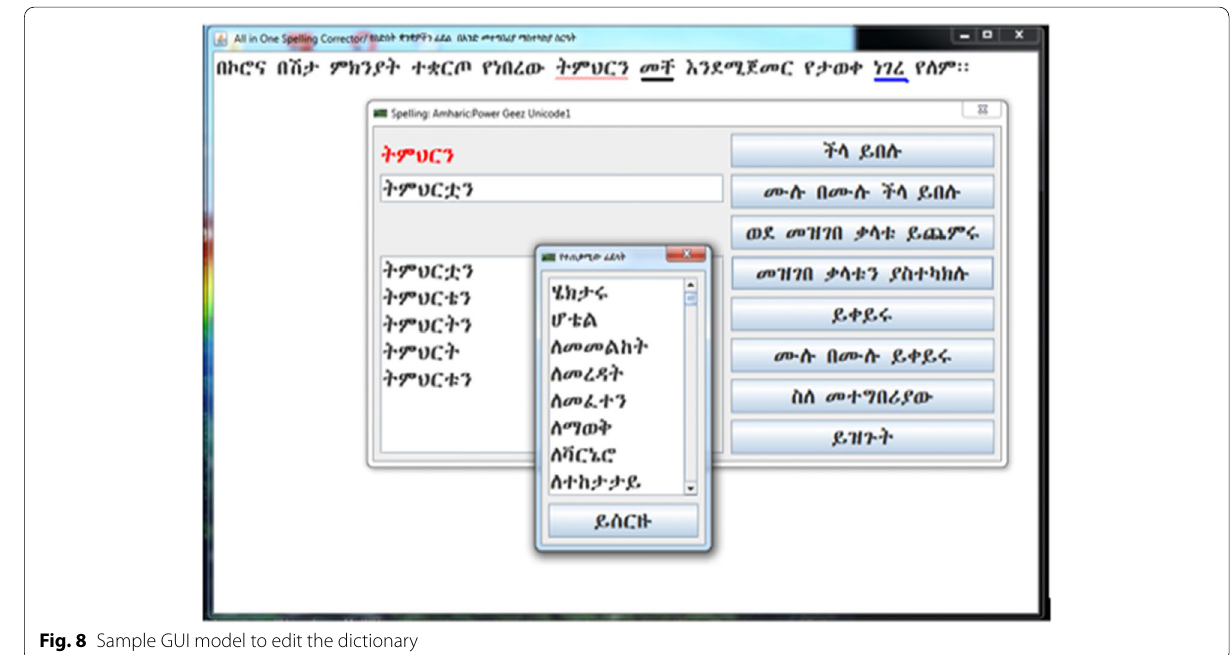
Fig. 8 Sample GUI model to edit the dictionary